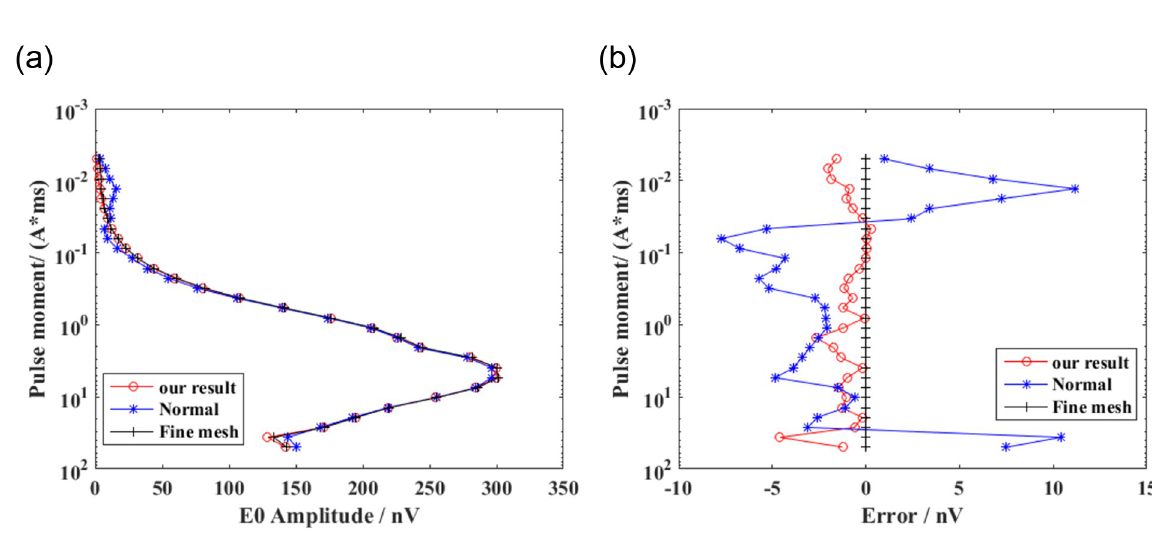
Fig 15. Forward calculation results with one deep water-bearing object. (A) Amplitude and (B) error of the FID signal.